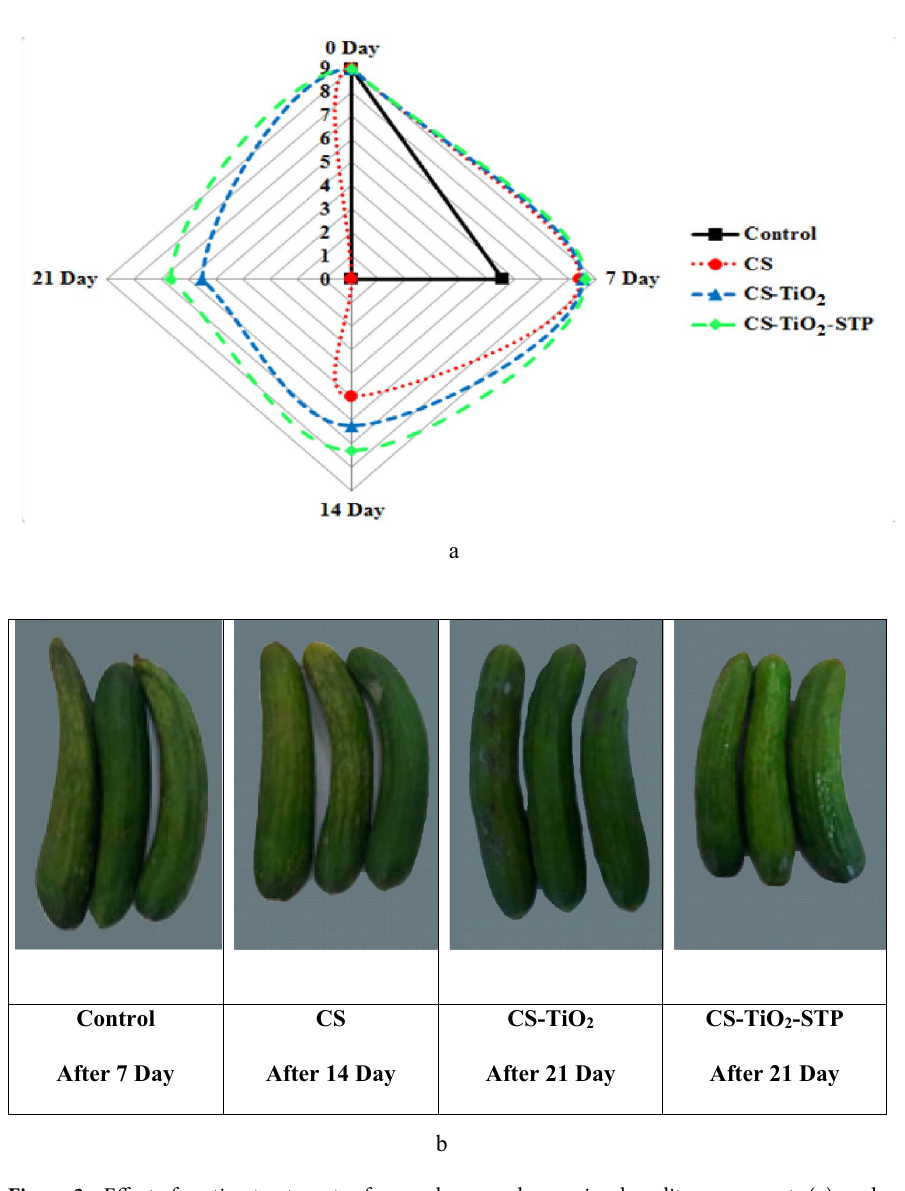
Figure 3. Effect of coating treatments of cucumber samples on visual quality assessments ( a ), and optical evaluation during the storage period ( b ); (Control) refers to the treatment with distilled water, CS is the (Chitosan), CS-TiO 2 is Chitosan/Titanium Dioxide Nanoparticles, while CS-TiO 2 -STP is (Chitosan/Titanium Dioxide Nanoparticles/Sodium